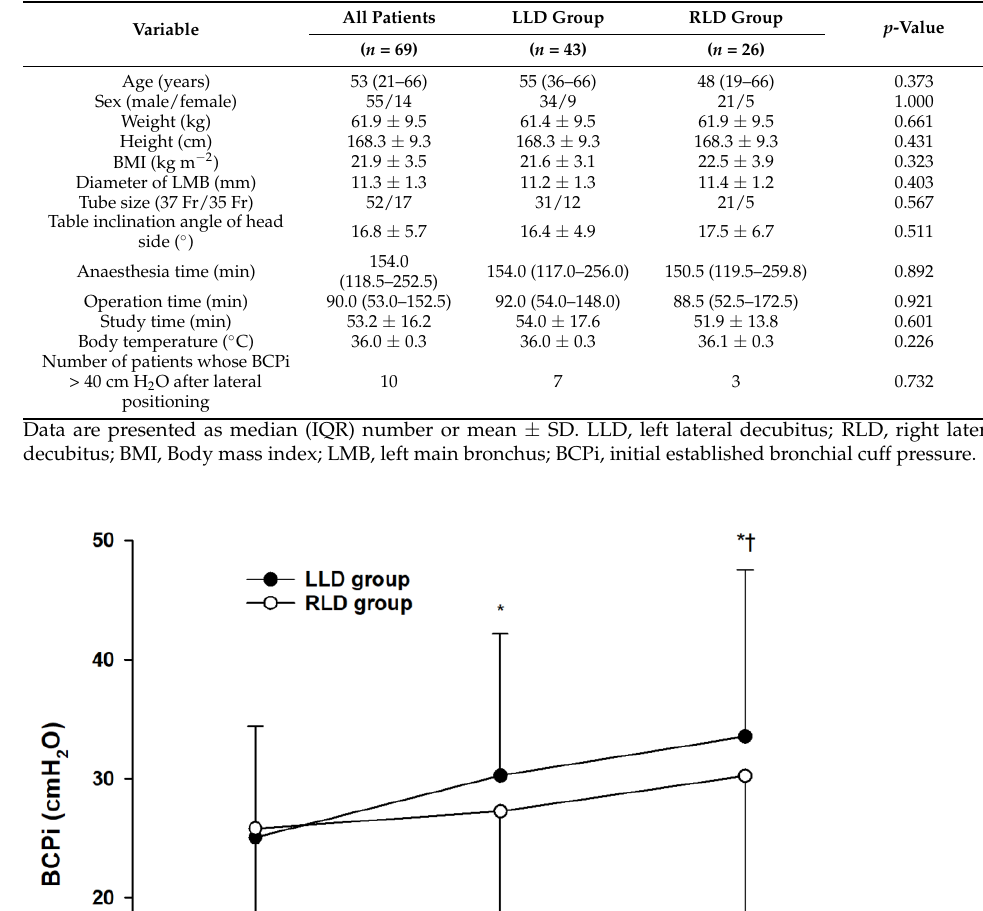
Table 1. Characteristics of patients before and during study period. Variable